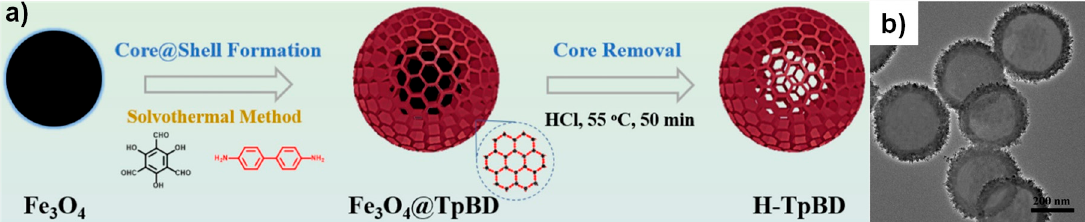
Figure 15. ( a ) Schematic illustration of the synthesis protocols and chemical structures of the H-TpBD. ( b ) TEM image of the synthesized H-TpBD. Reprinted with permission from [77]. Copyright (2018) Elsevier